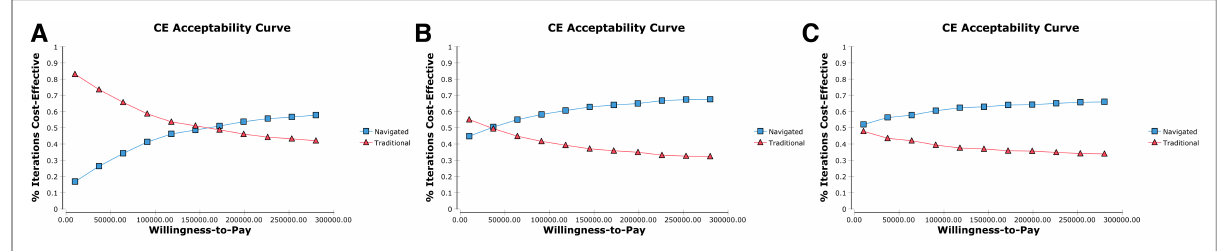
FIGURE 4 The cost-effectiveness (CE) acceptability curves depicted the relationship between the willing-ness-to-pay (WTP) threshold (Chinese Yuan per quality-adjusted life-year) on the X axis and the proportion of simulations in monte carlo simulation that had an incremental cost-effectiveness ratio below the given WTP thresholds. ( A – C ) Indicated the simulations in institutes at which 300, 200 and 100 cases of navigated surgery, respectively.